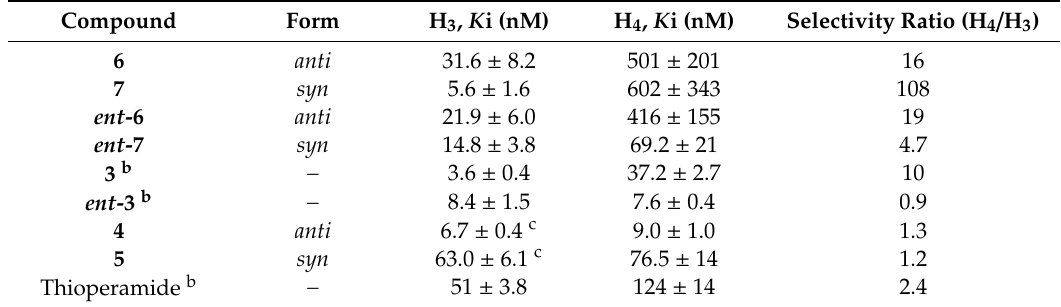
Table 1. Binding a ffi nities of the compounds for the human H 3 and H 4 receptor subtypes. a Compound